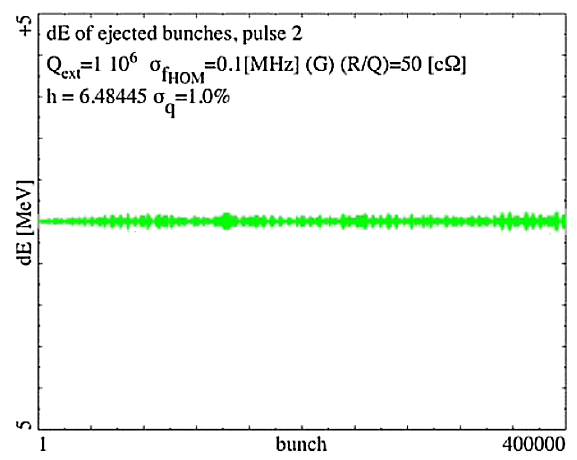
FIG. 78. (Color) dE at ejection [ (cid:3) 5 MeV ] (equivalent to Figs. 60 and 75 but Q ext ¼ 10 6